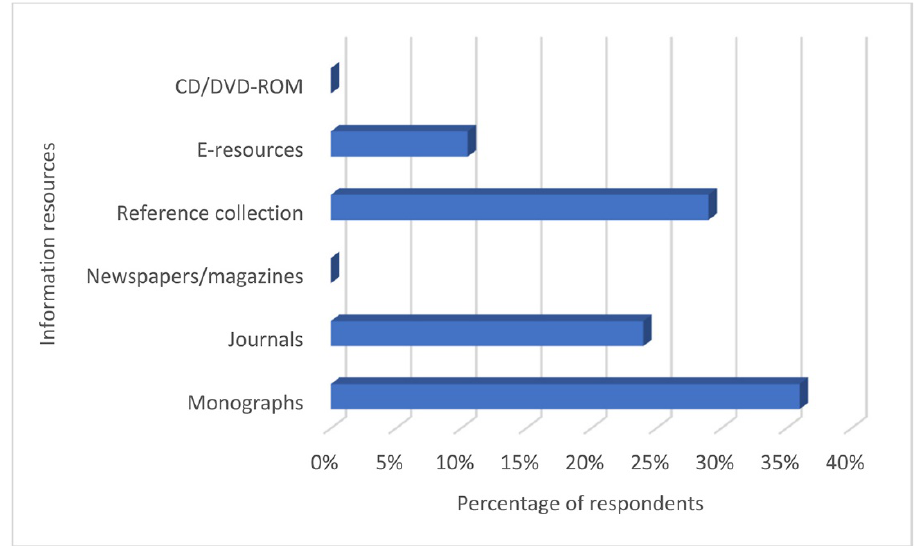
Figure 3 Major information resources in Nigerian medical library